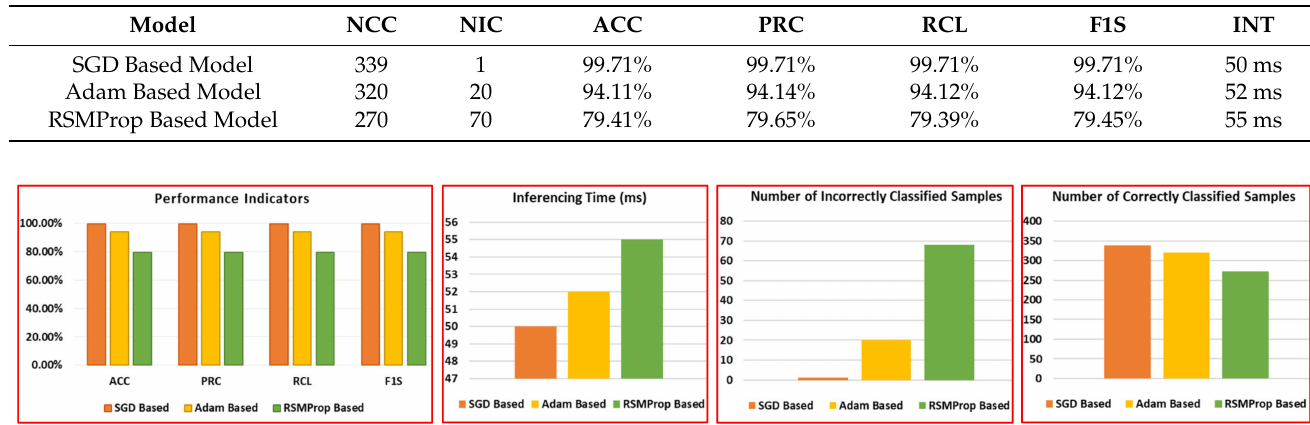
Table 2. Summary of performance indicators of the three model-based techniques.